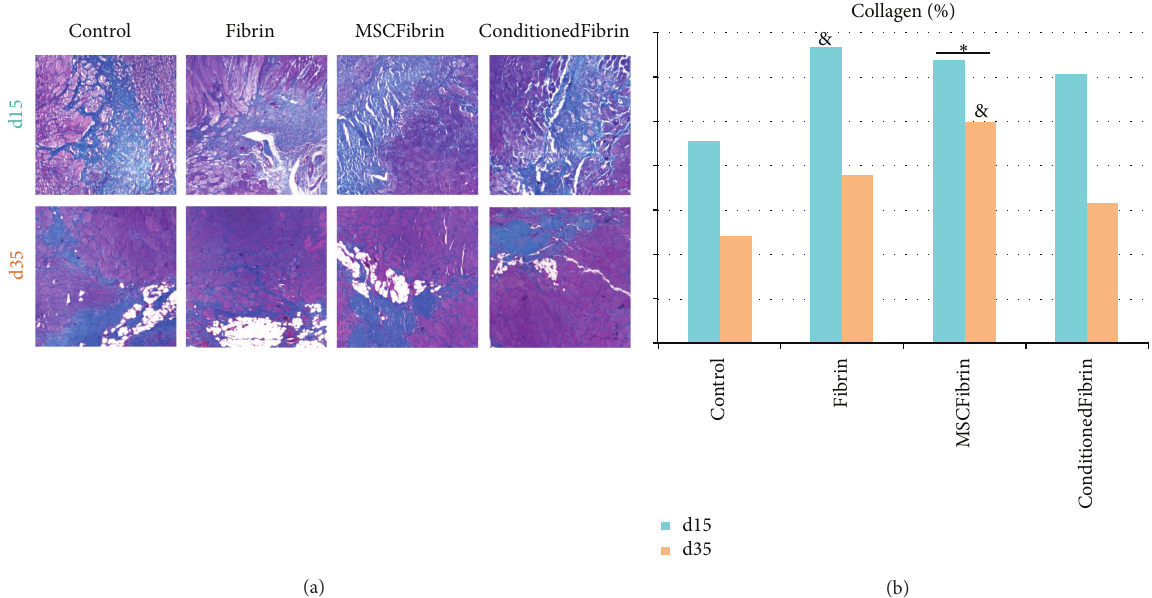
Figure 5: Histological analysis of tibialis anterior (TA) muscles from the Control and treatment groups (after choosing fibrin glue—Tisseellyo as the preferred vehicle) evaluated at d15 and d35: Masson’s Thricrome/eosin-stained sections appearance (magnification: 40x). Scale bar: 50 𝜇 m (a). Histomorphometric quantification of mean collagen fraction (b). ∗ Significantly different from Control (d15 and d35 data pooled together; 𝑃 < 0.05 ); & significantly different from Control at the same time point ( 𝑃 < 0.05